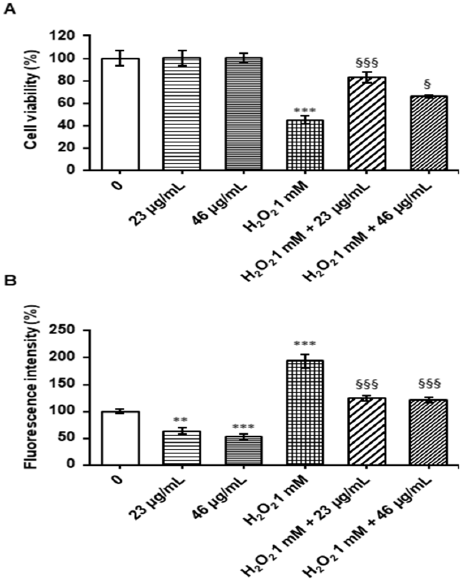
Figure 2. Viability assay and ROS evaluation. Caco-2 cells were treated with a digested cinnamon extract at 23 and 46 µ g/mL polyphenols for 24 h, with 1 mM H 2 O 2 for 1 h and with 1 mM H 2 O 2 for 1 h after digested cinnamon extract pretreatment. In panel ( A ), the cell viability evaluated by MTT assay is reported; panel ( B ) shows the level of fluorescence after cells incubation with 5 µ M H 2 DCFDA. Data are expressed as a percentage against the untreated cell line used as a control and are shown as mean ± SEM from three independent experiments. Statistical significance: ** p < 0.01, *** p < 0.001 respect to untreated cell line; § p < 0.05, §§§ p < 0.001 respect to H 2 O 2 -treated cell line.